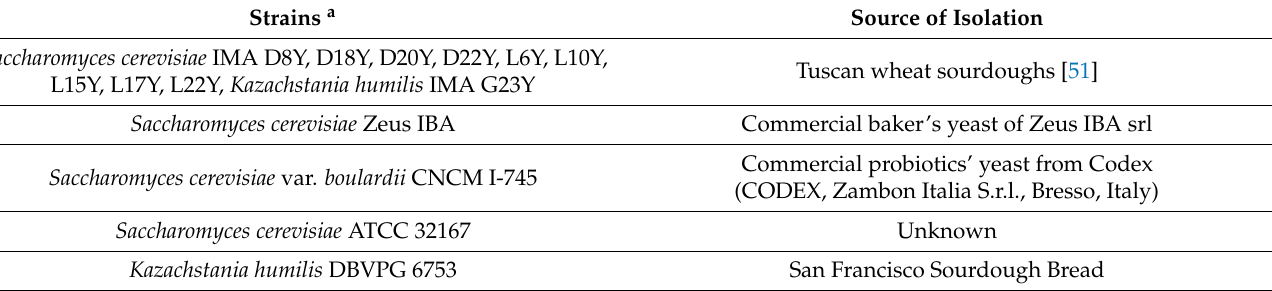
Table 1. Yeast isolates and reference strains used in this